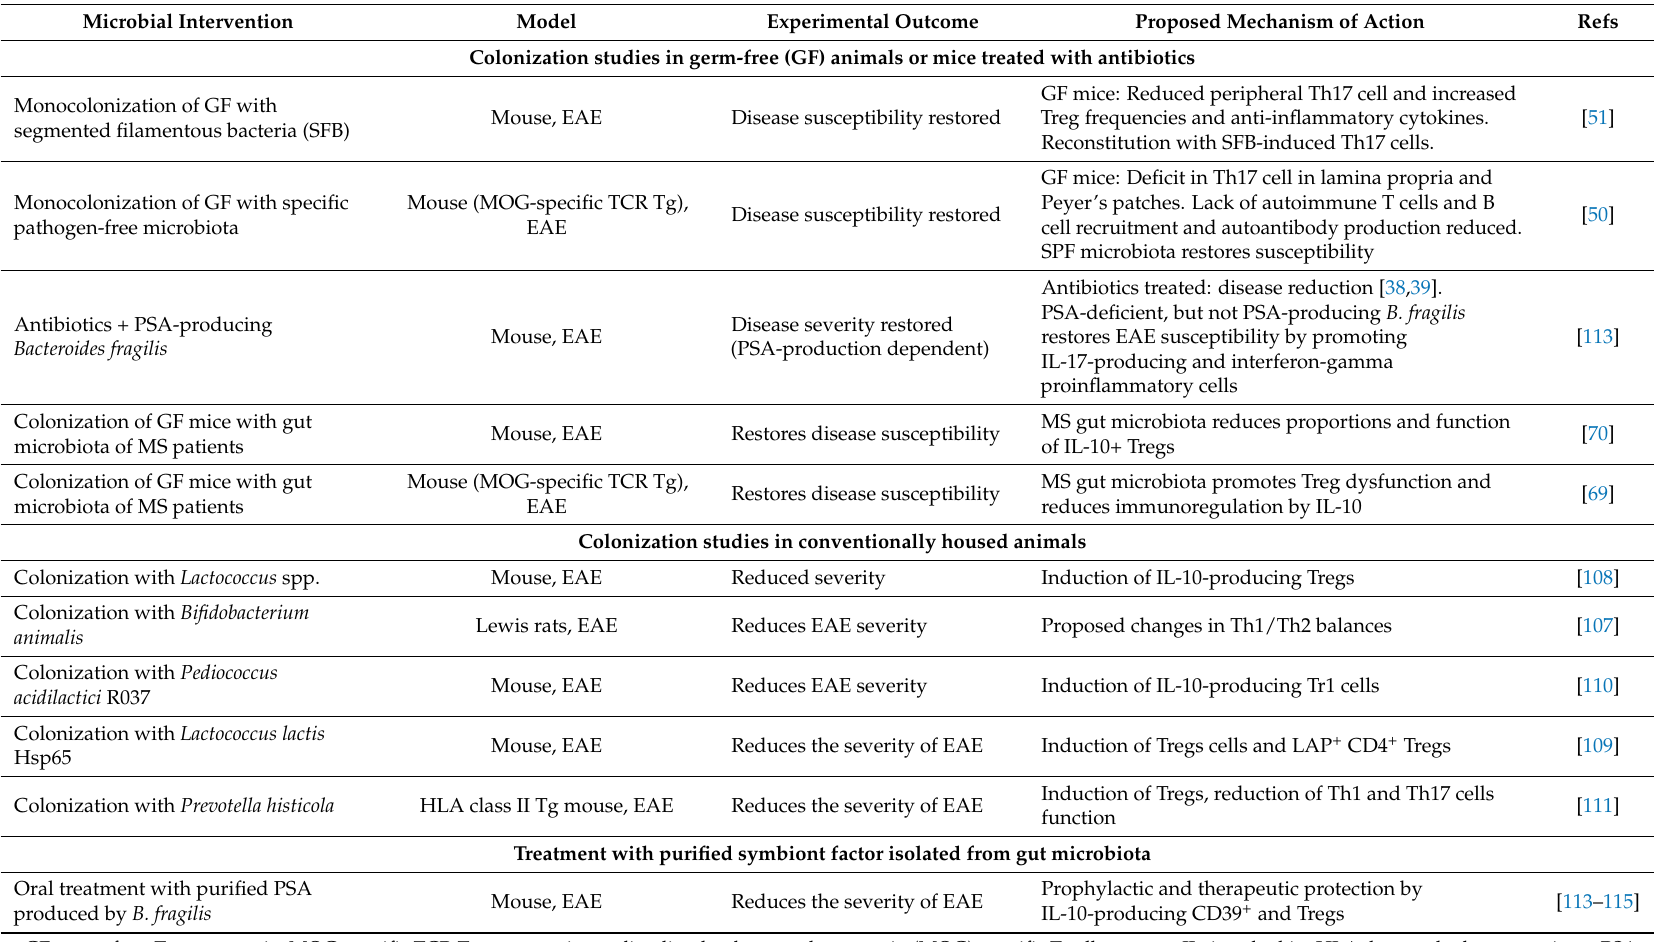
Table 1. Experimental interventions of the gut microbiota that modulate CNS inflammatory